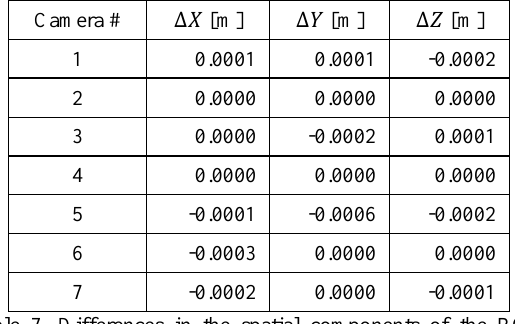
Table 11. Differences in the spatial components of the ROPs between the one-round mini calibration and the full major calibration